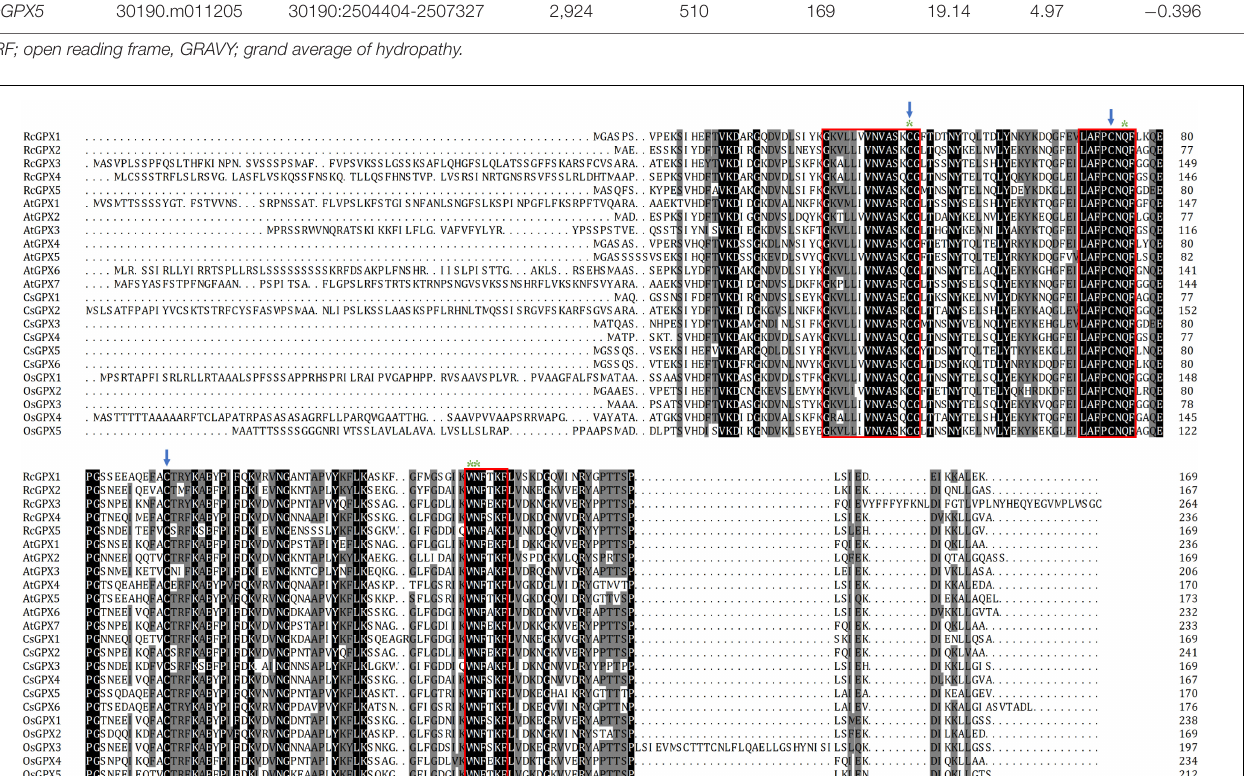
Frontiers in Plant Science |